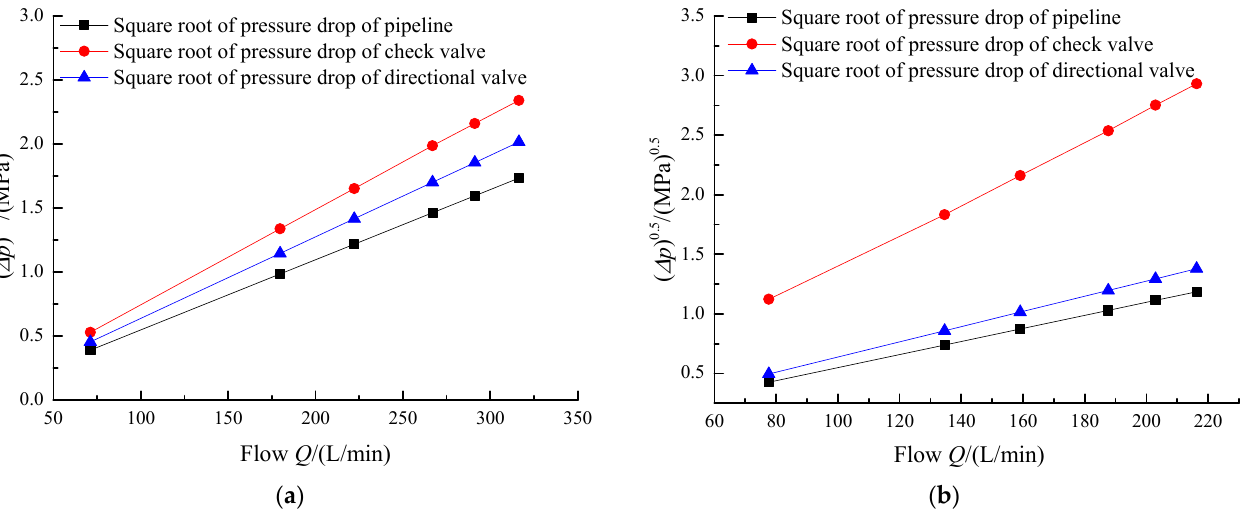
Figure 10. The relationship between flow and square root of differential pressure at all levels when hydraulic cylinder is operated under DN20 pipeline diameter: ( a ) retracted; ( b ) extended.